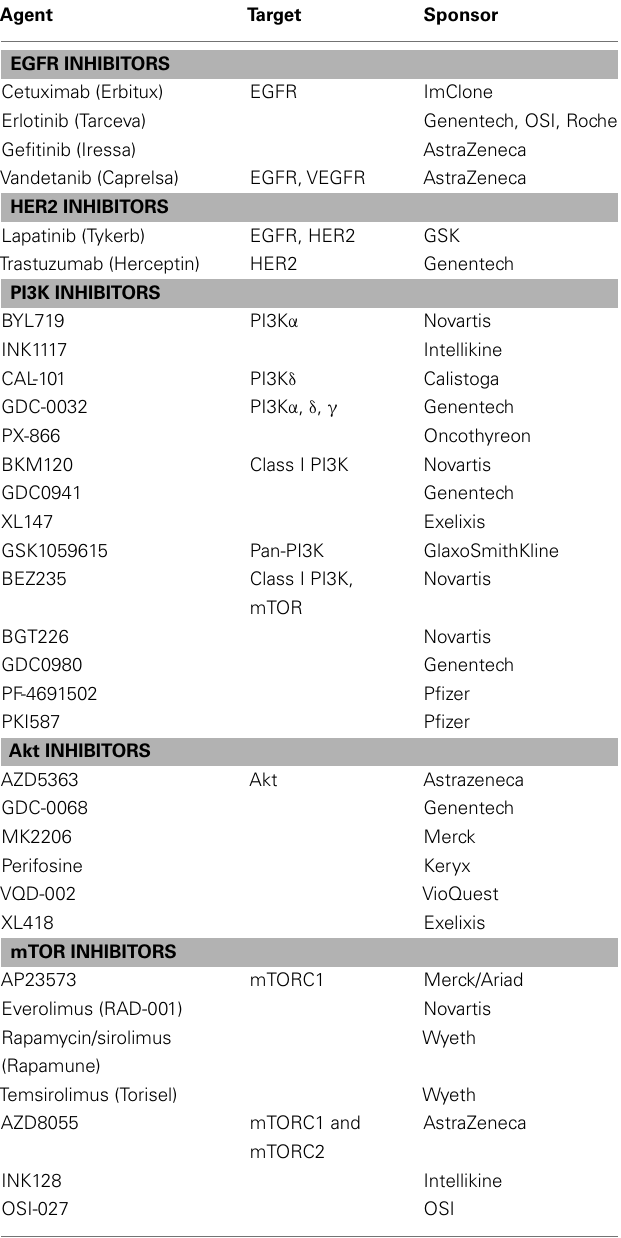
Table 1 | Drugs targeting the HER-PI3K pathway for cancer